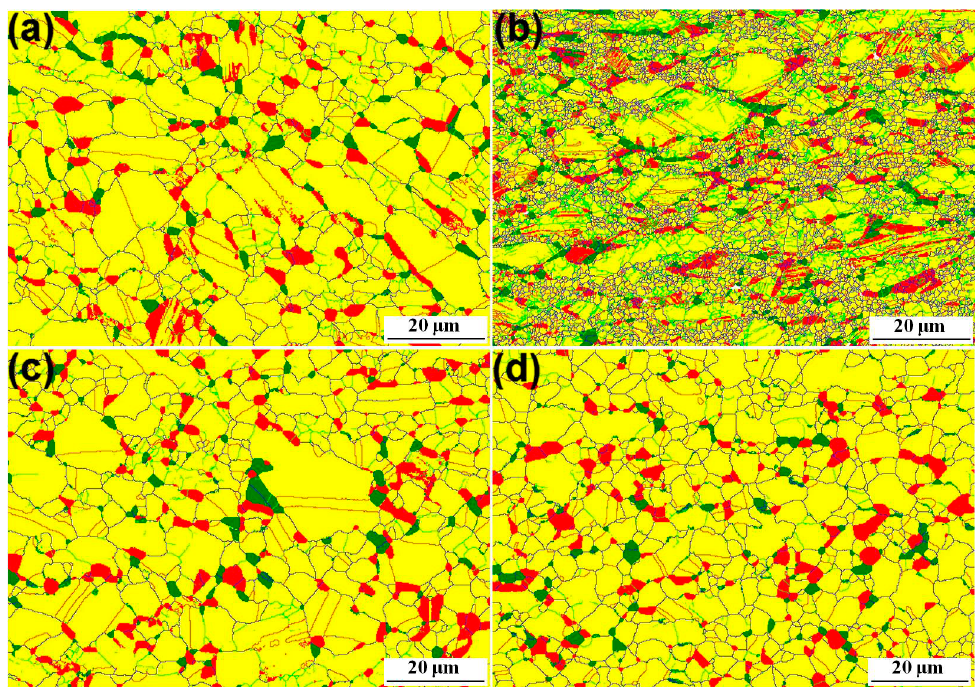
Figure 7. Electron backscattered diffraction (EBSD)-derived phase maps with highlighted boundaries showing the microstructure of the alloy after compression deformation under 1000 °C/10 − 2 s − 1 / ε = 0.11 ( a ), 1000 °C/10 − 2 s − 1 / ε = 0.36 ( b ), 1000 °C/10 − 4 s − 1 / ε = 0.11 ( c ) and 1000 °C/10 − 4 s − 1 / ε = 0.36 ( d ). (Yellow— γ phase, red— α 2 phase, green— β / β o phase; blue line—HAGB, green line—LAGB, red line—TB).